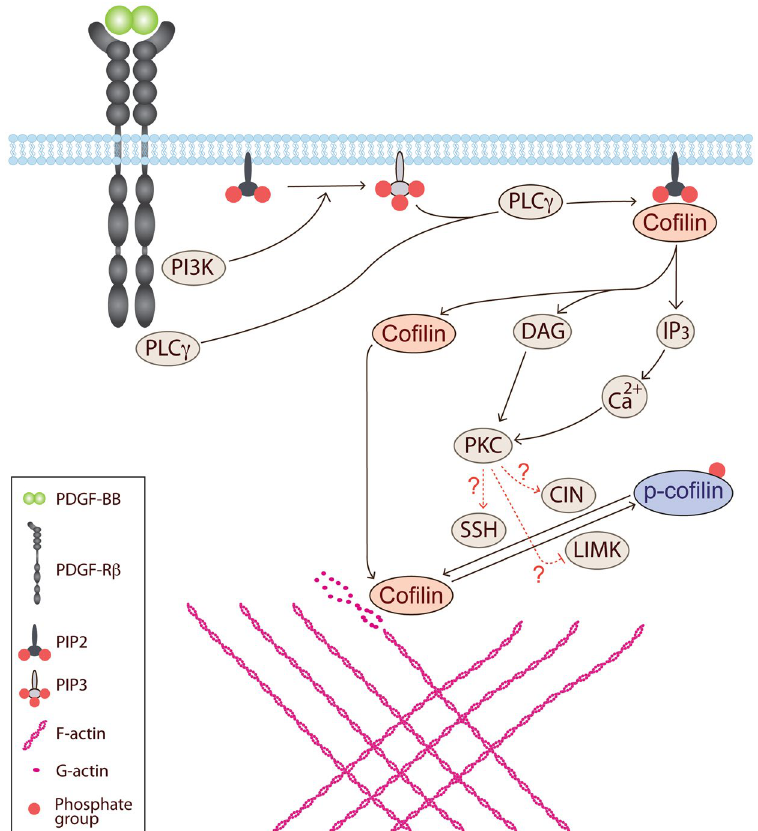
Figure 7. Proposed signaling events involved in PDGF-enhanced matrix contraction. Based on our findings, we propose that upon PDGF-R β activation, activation of PKC downstream of PI3K and PLC γ mediates PDGF- induced cofilin dephosphorylation during PDGF-enhanced collagen gel contraction. These findings point to activation of slingshot (SSH) and/or chronophin (CIN) phosphatases downstream of PKC, which requires further